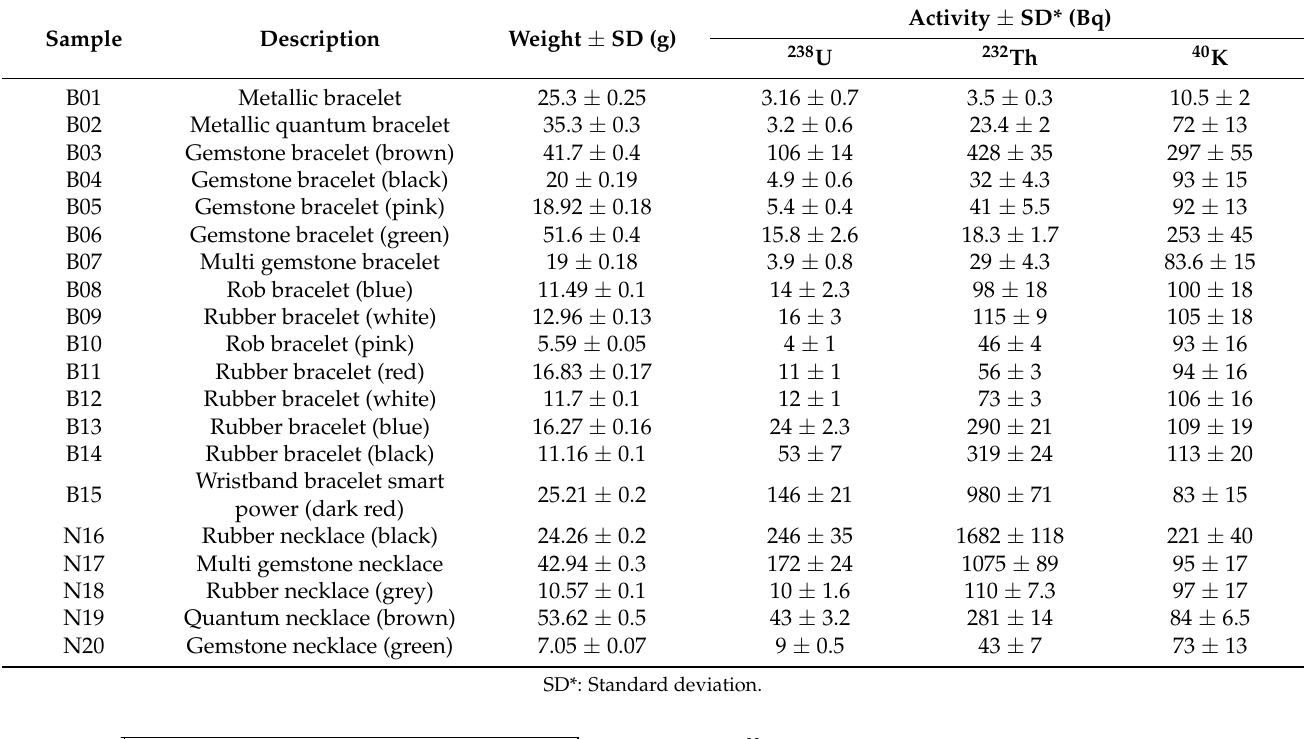
Table 5. Total activities (in Bq) for 238 U, 232 Th, and 40 K for each of the bracelets and necklaces.